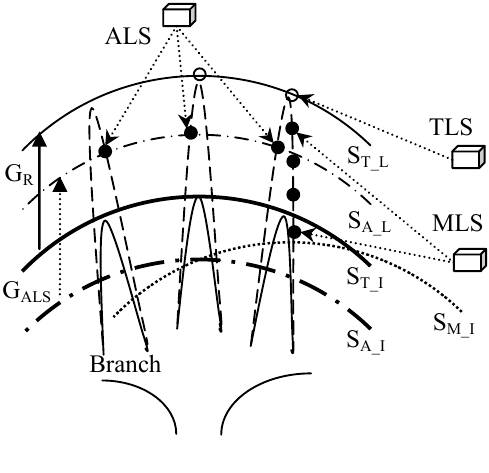
Figure 3. Schematic relationships between the measurements of tree heights and height growths in different laser scanning modes. See text for the definition of